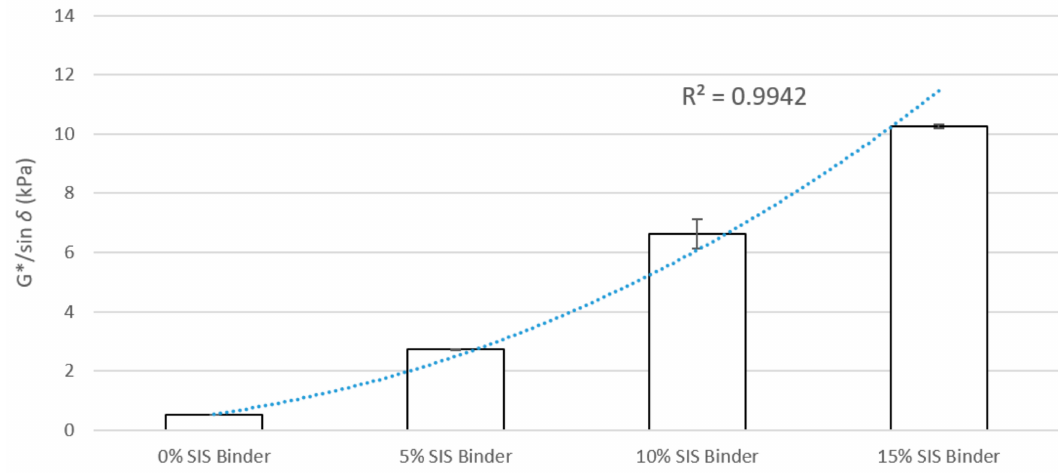
Figure 14. G* / sin δ at 76 ◦ C